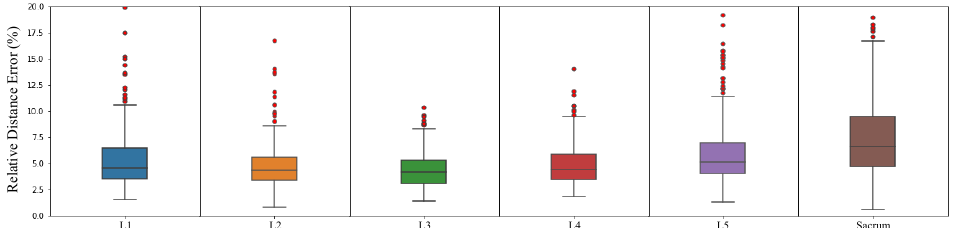
Figure 18. Box plot of landmark relative distance error except for outliers.